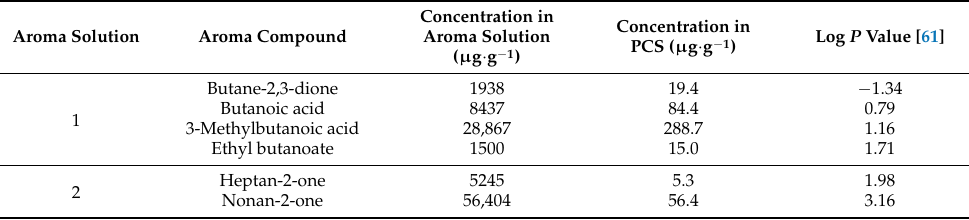
Table 3. Concentrations of aroma compounds in the aroma solutions 1 and 2, the resulting final concentrations in the model PCS samples and the log P value of each